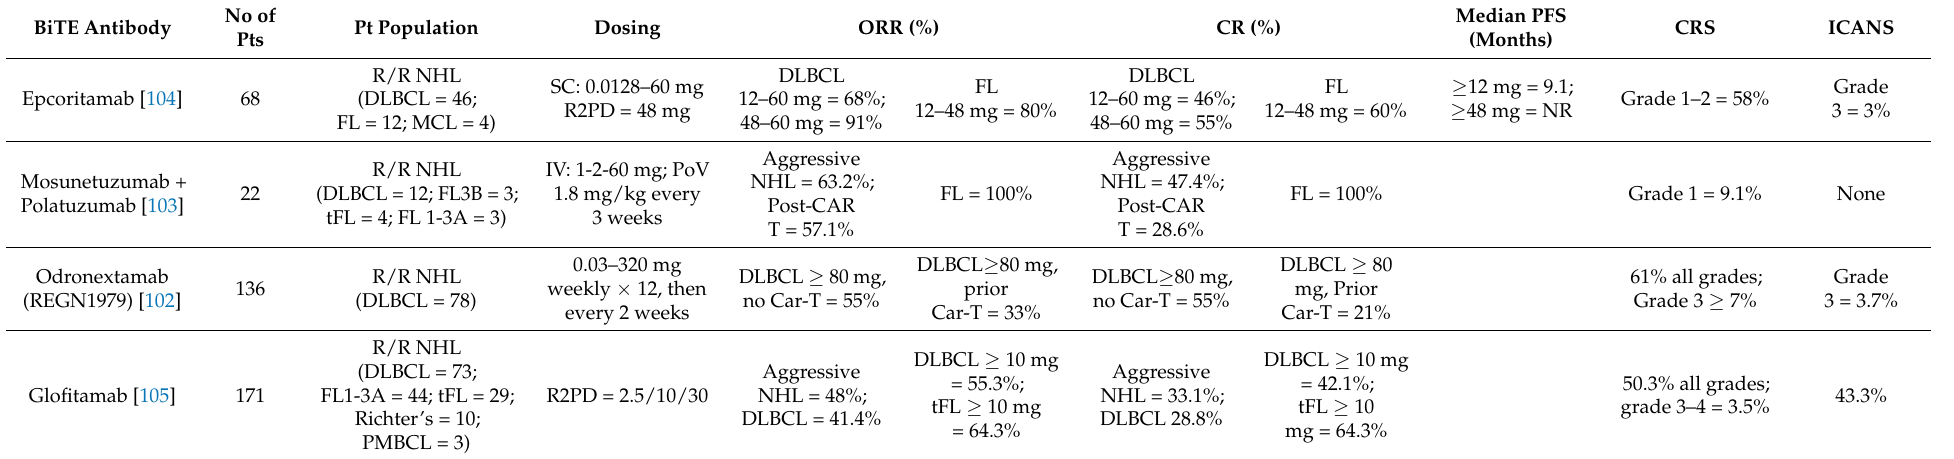
Table 4. Trials of BiTE antibodies in B-cell non-Hodgkin’s